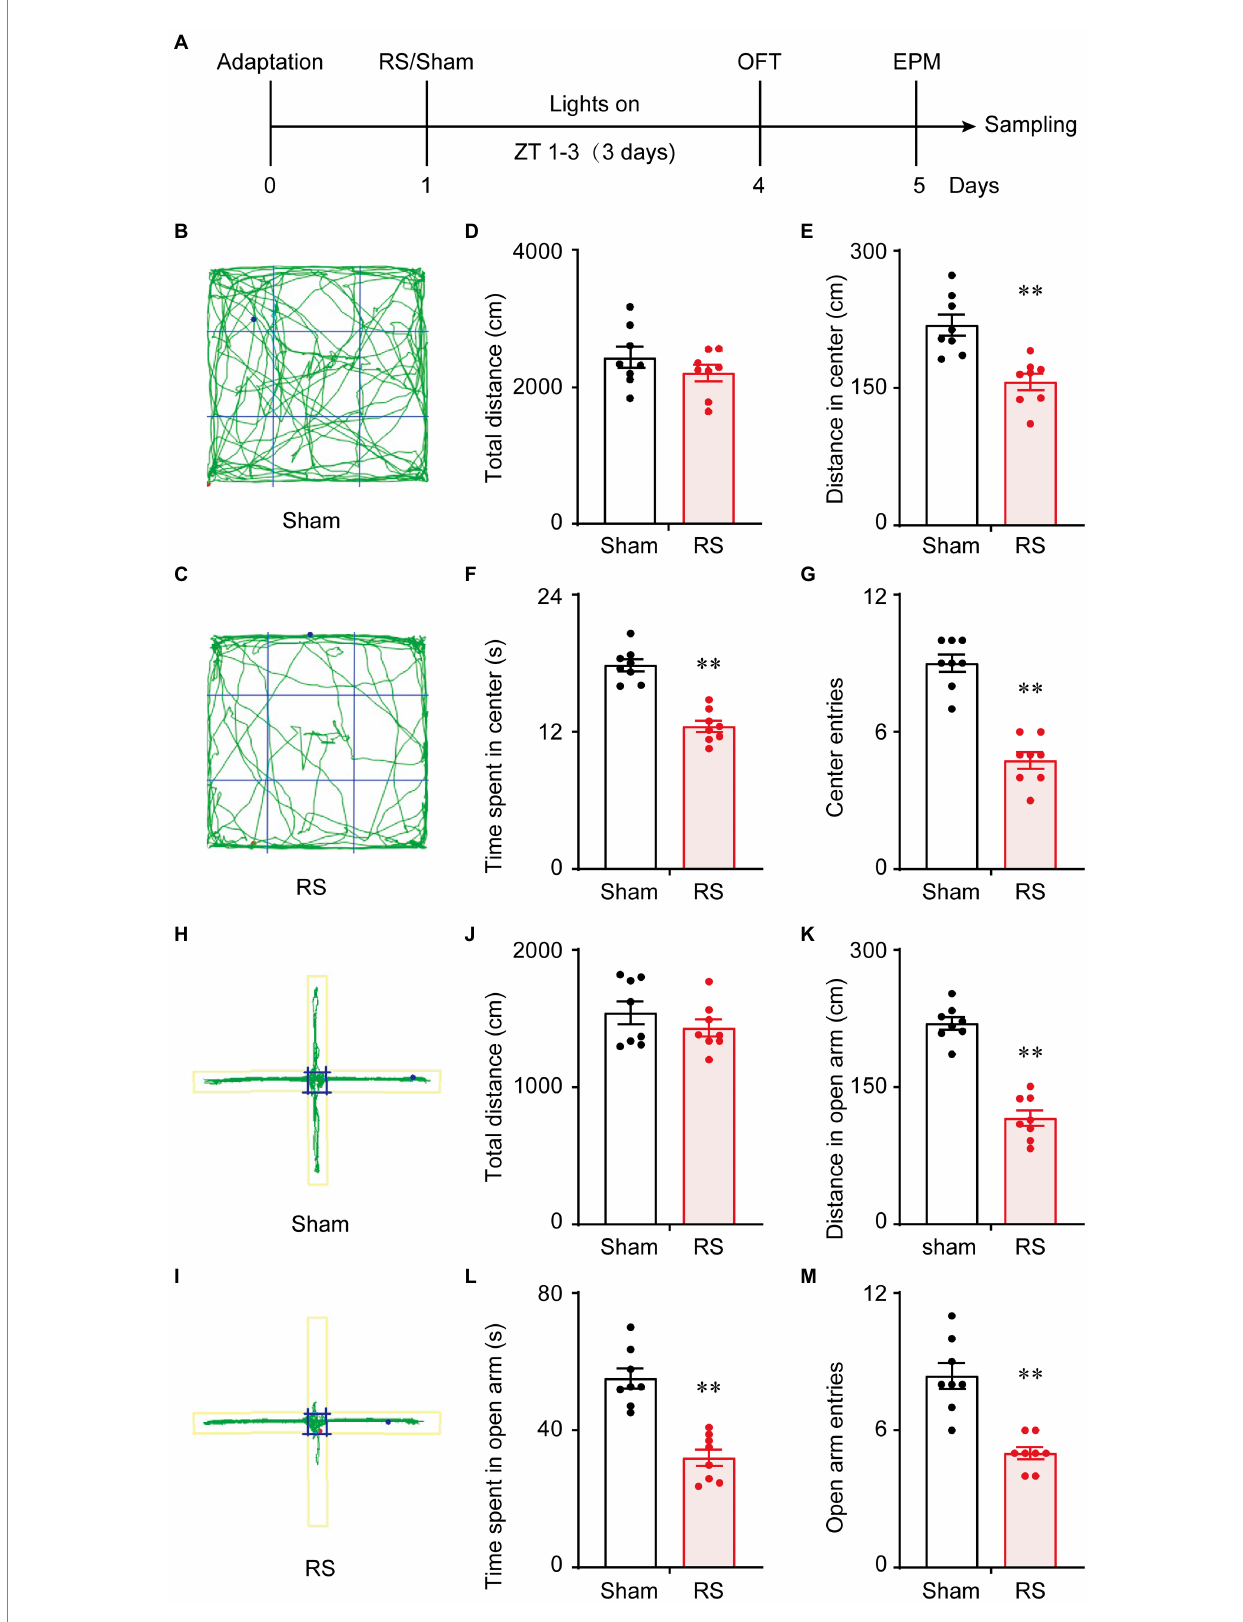
FIGURE 1 Behavioral experimental schedule and acute restraint stress induced anxiety-like behavior. Schedule for conducting the OFT and EPM (A) . OFT trajectory diagram of the sham group (B) and the RS group (C) . Total distance traveled for 5 min in the OFT, the distance and time spent in the center, and the number of times the mice entered the center of the OFT (D–G) . EPM trajectory diagram of the sham group (H) and the RS group (I) . Total distance traveled during 5 min in the EMP, the distance and the time spent in the open arm, and the number of times the mice entered the open arm of the EPM (J–M) . ** p < 0.01 vs. sham, n = 8. RS, restraint stress; OFT, open field test; EPM, elevated plus maze; ZT, Zeitgeber